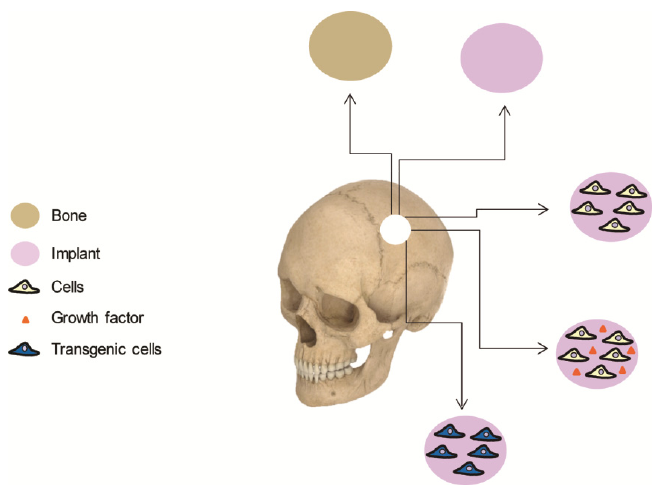
Figure 1. Current clinical methods and experimental cell-based approaches for cranial bone repair. The figure includes an image retrieved from https://free3d.com/es/modelo-3d/caucasoid-male-skull-4837.html, accessed on 30 August 2021.